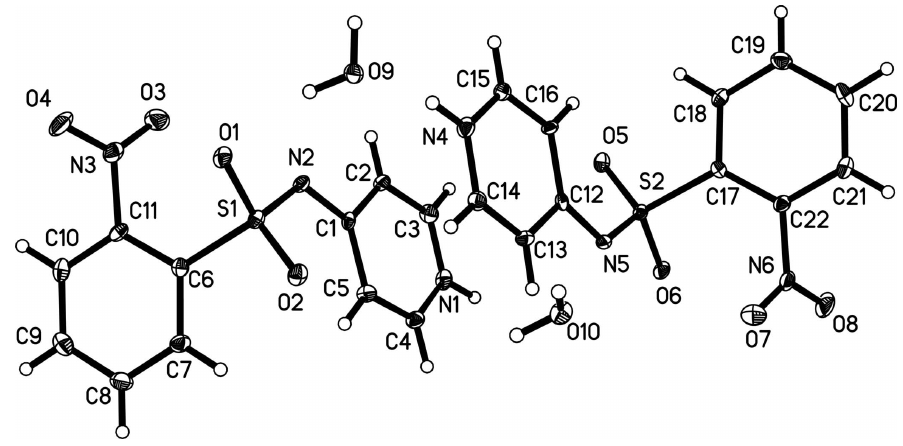
Figure 1 View of the molecule of title compound showing the atom-labelling scheme. Displacement ellipsoids are drawn at the 35% probability level (arbitrary spheres for the H